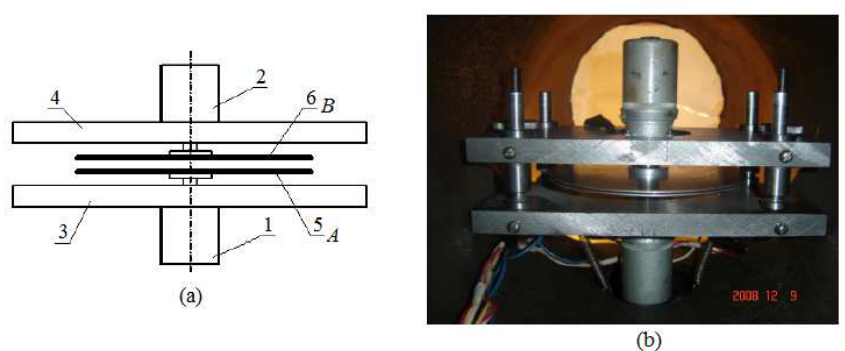
Figure 14. Samokhvalov’s device [118] for studying the mass-dynamical effect: ( a ) schematic diagram: 1 and 2 are axes with electric motors mounted on them, 3 and 4—steel boards with electromagnetic brakes fixed on them, 5 and 6—nonferromagnetic disks with a radius R = 8.25 cm rigidly fixed to the flanges of the rotors of electric motors (the gap between the disks is from 1 to 6 mm or more, the maximum frequency of disks spin of the order of 100–120 1/s); ( b ) general view of the